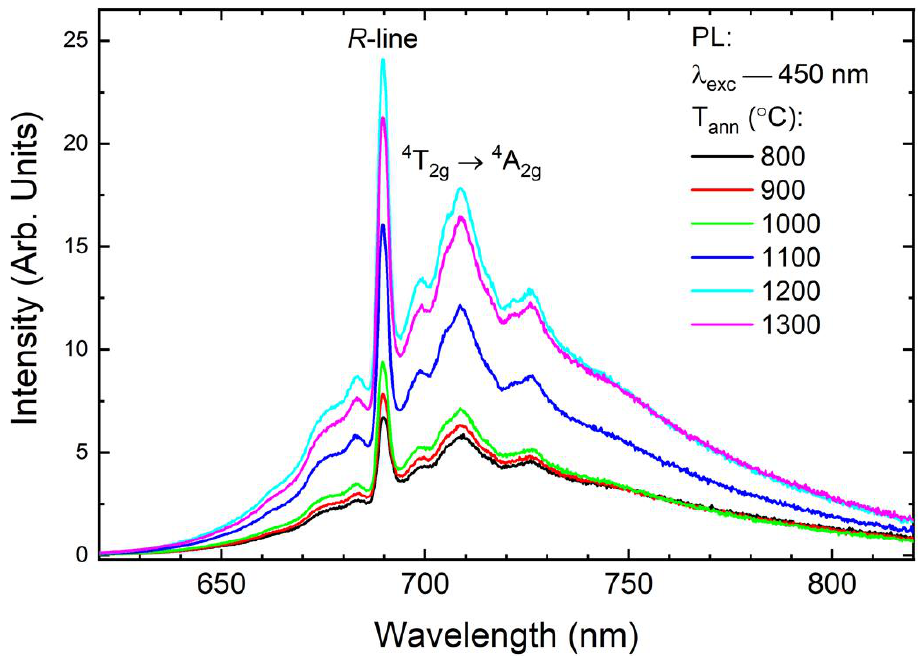
Figure 6. Photoluminescence spectra of the YAGG: 1% Cr nanopowders as a function of annealing temperature. Excitation 450 nm, at room temperature.